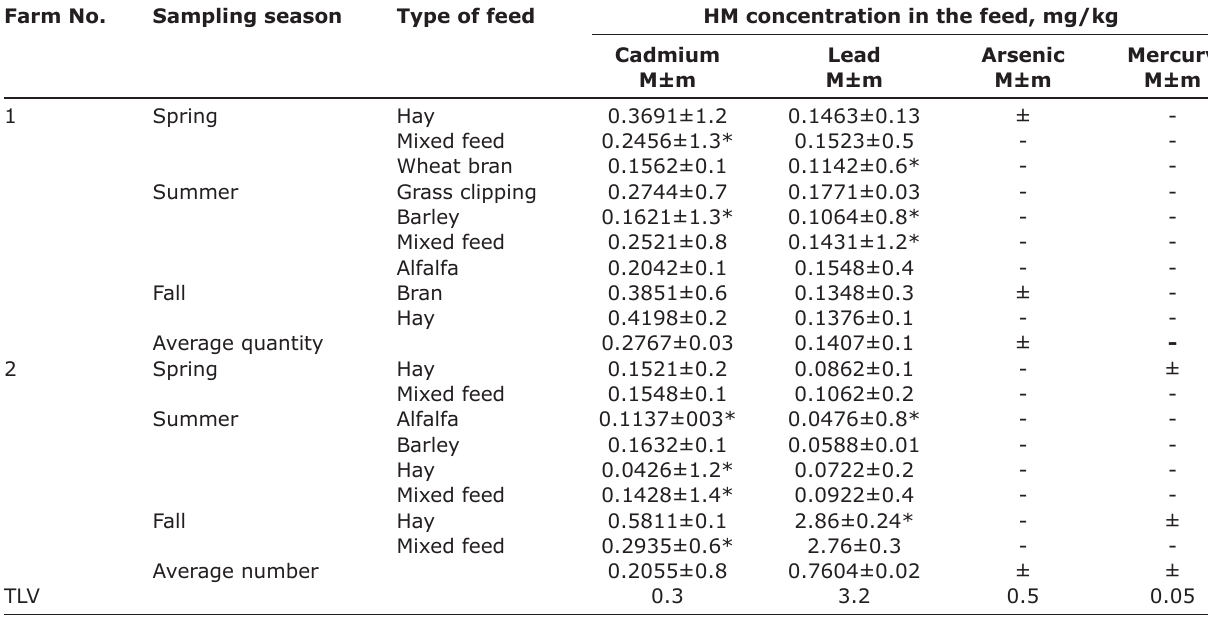
Table-2: The concentration of HM in horse feed produced in two farms of the Almaty region. Farm No. Sampling